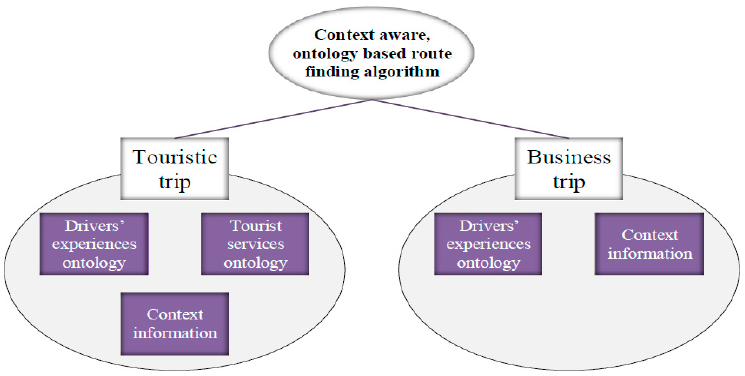
Figure 4. Two cases of the proposed route finding algorithm.